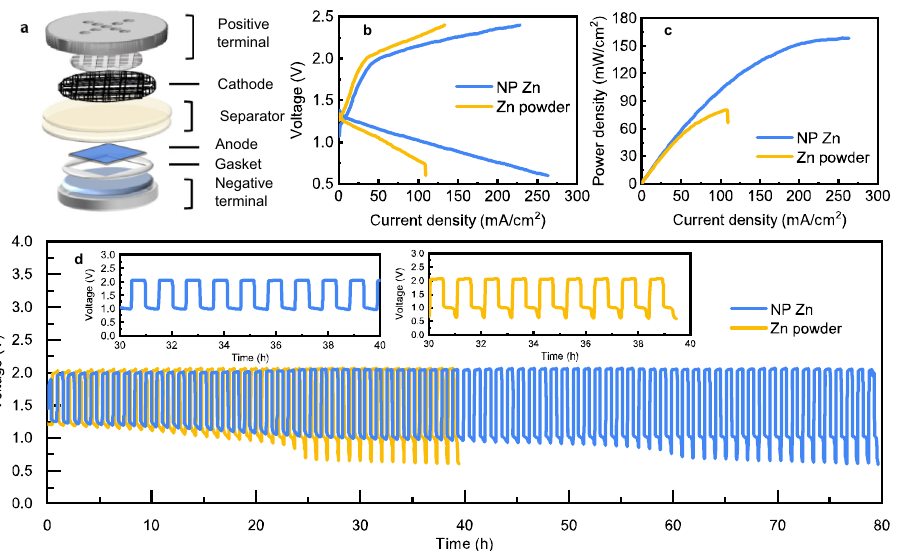
Fig. 6 Electrochemical performances of the Zn||Pt/C/IrO 2 full cells with NP Zn and Zn powder anodes. a Schematic of the Zn-air coin cell used in this study. b Discharging and charging polarization curves and c the corresponding power density curves for discharging. d Voltage vs. time curves at 10 mA/ cm 2 and 10% DoD, where the insets highlight those during the 30 – 40th